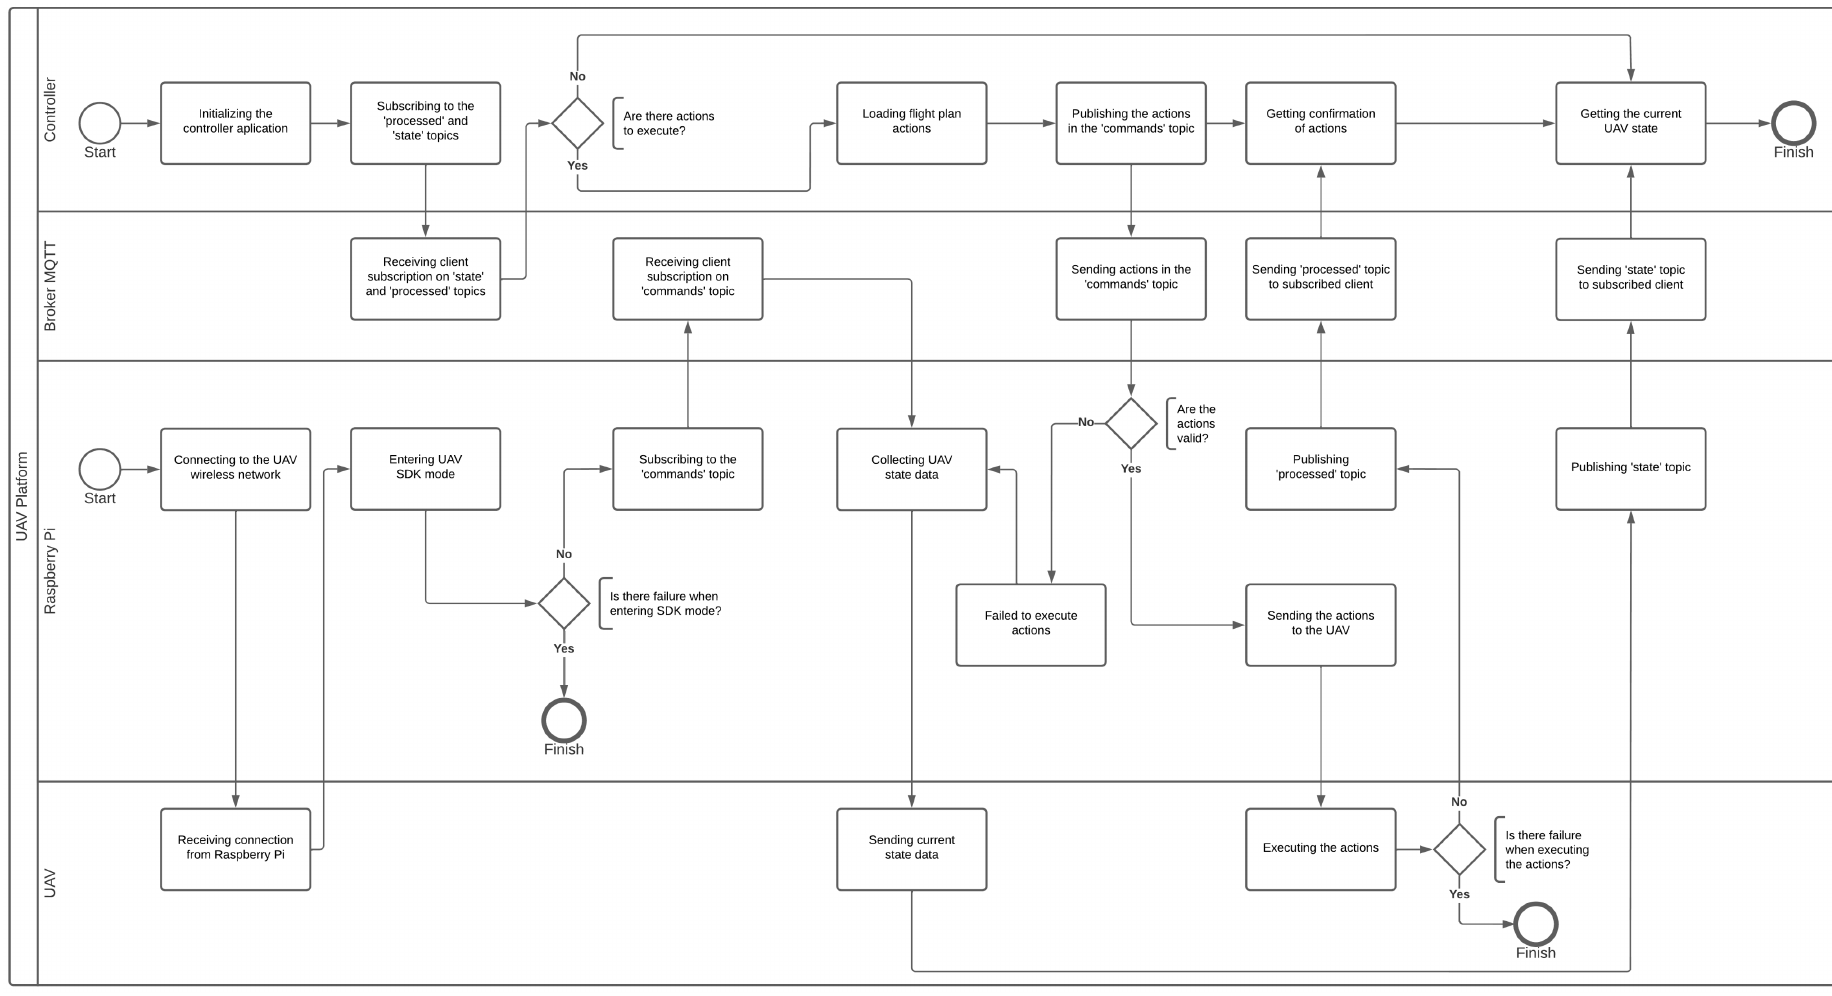
Figure 5. Platform BPMN